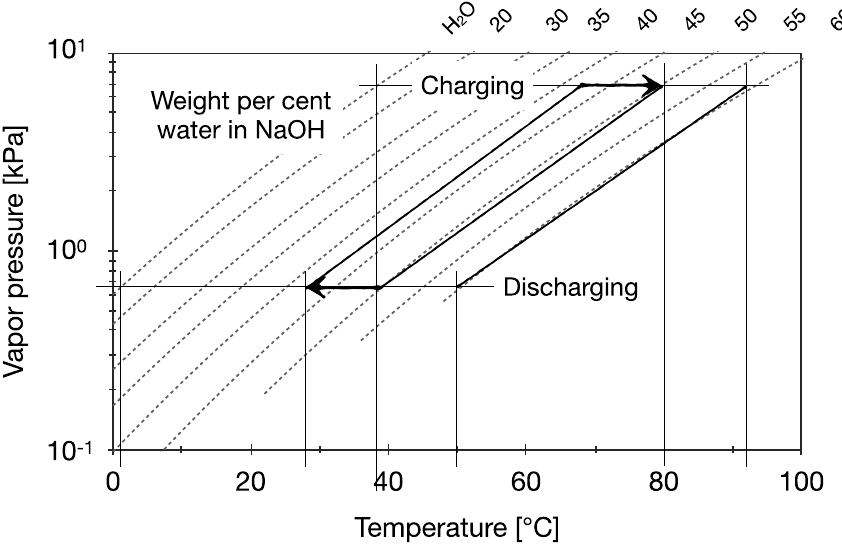
Figure 1. Vapor pressure vs. temperature diagram of varying aqueous sodium hydroxide concentrations [11].